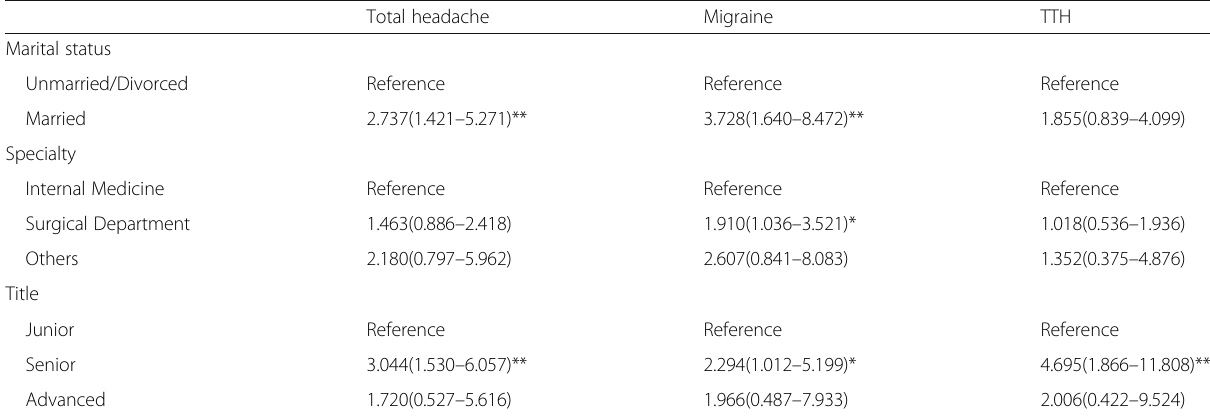
Table 7 Multivariable adjusted odds ratios (95% confidence interval) for total headache, migraine, and tension-type headache (TTH) among